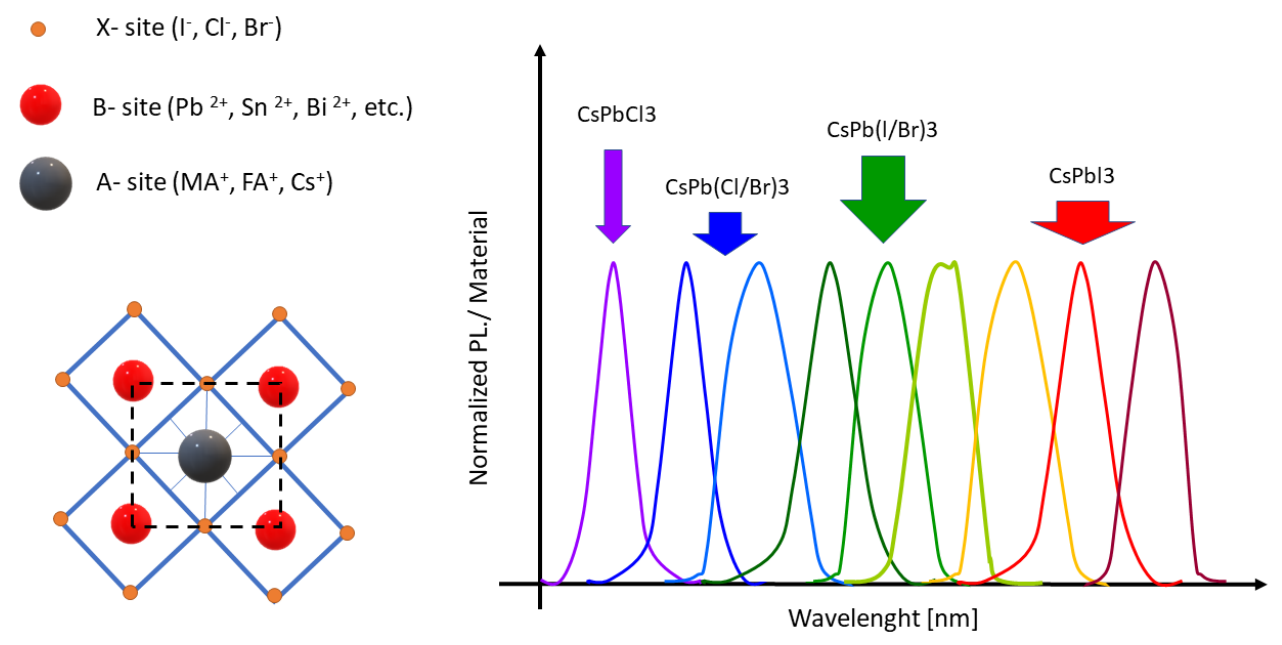
Figure 7. Emission ranges of various material QDs under UV excitation, based on [99] and typical metal halide perovskite construction.